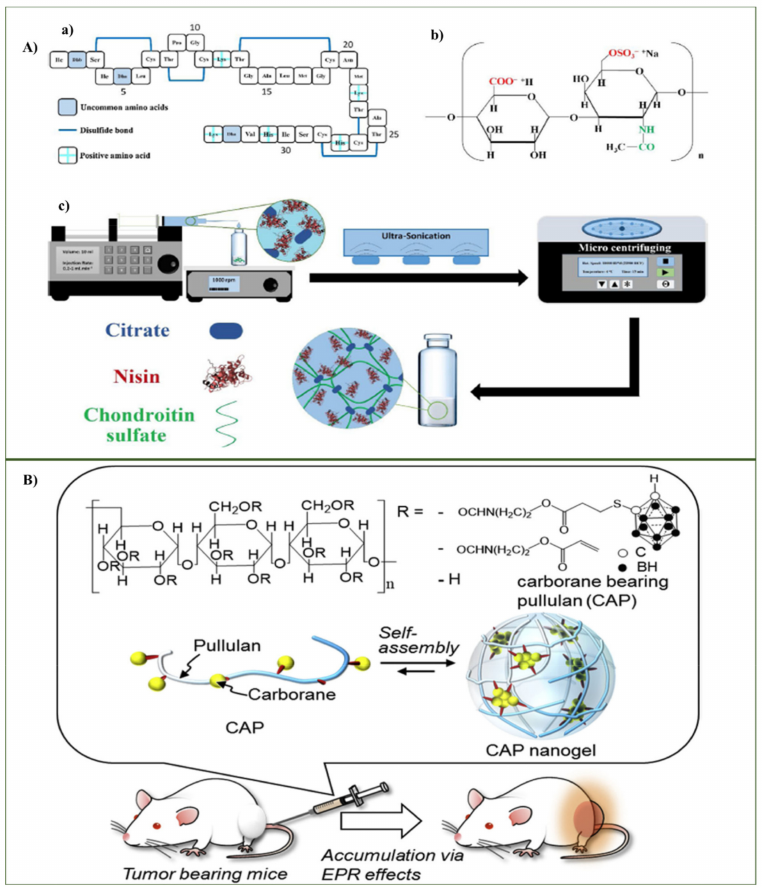
Figure 3. ( A ) ( a ) Nisin sequence ( b ) chemical structure of a Chondroitin sulfate unit ( c ) schematic